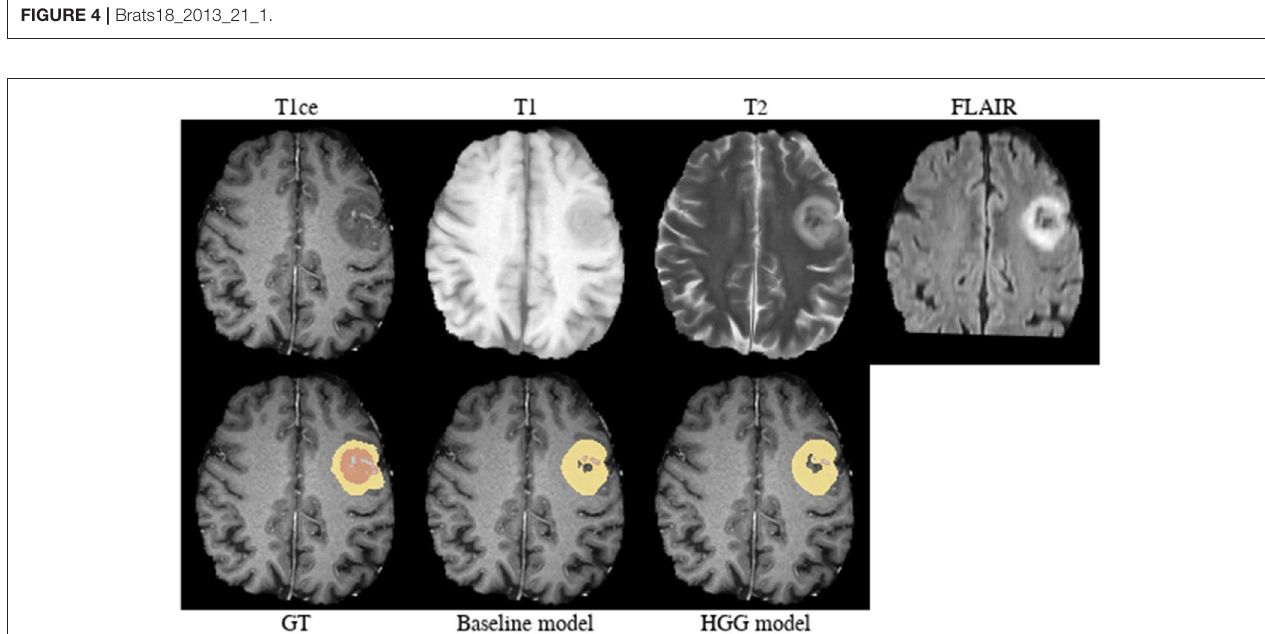
FIGURE 4 | Brats18_2013_21_1.